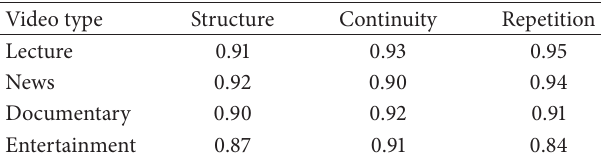
Table 2: Assessment outcome for different types of videos. Video